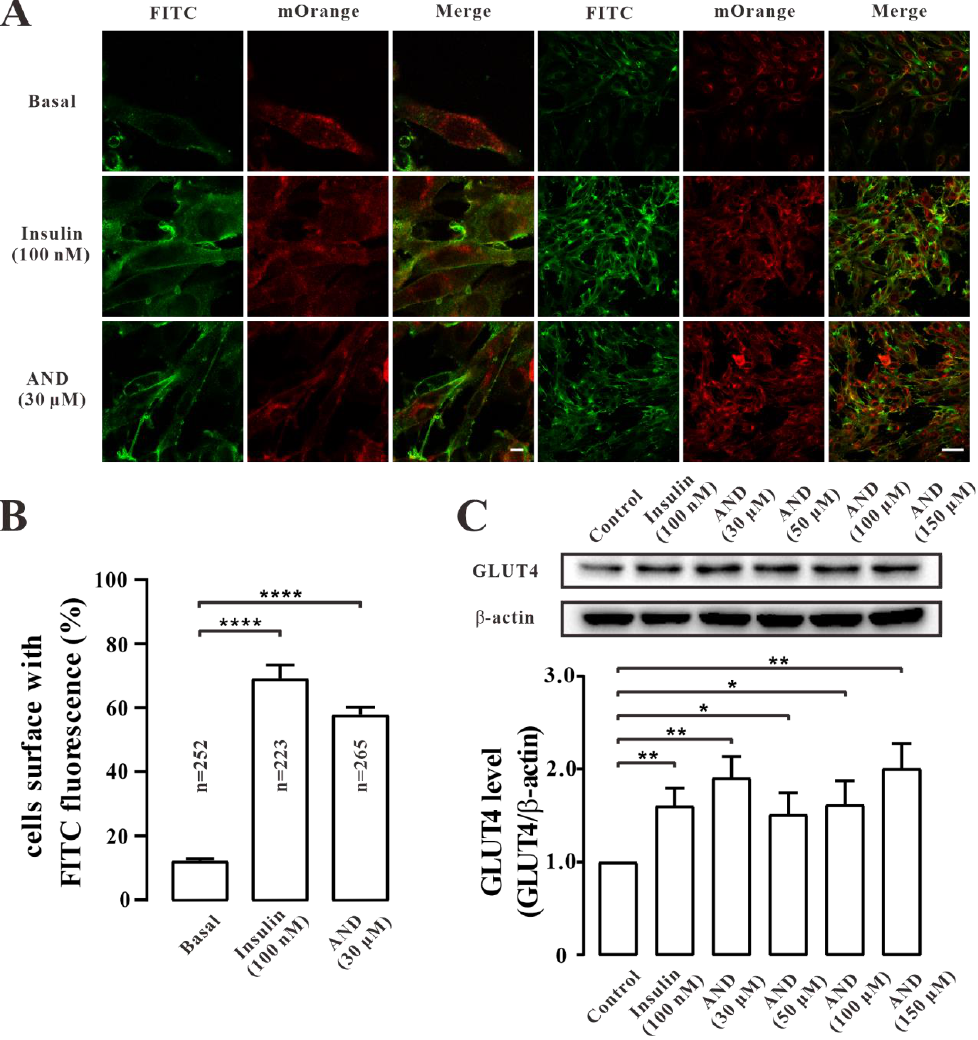
Figure 5. AND promoted GLUT4 expression and fusion into plasma membrane. ( A ) FITC fluores- cence analysis of L6 cells treated with AND or Insulin. Scale bar: 10 μm for single-cell images and 50 μm for multi-cell images. ( B ) The number of GLUT4-mOrange-positive cells, the data represent the mean ± s.e.m. of values from three separate experiments with between 200 and 300 cells examined in each experiment. ( C ) The expression level of GLUT4 after treatment with 100 nM insulin or different concentrations of AND for 30 min in L6 cells. The control group was considered as 1 for data analysis. The data represent the mean ± s.e.m. of values from three separate experiments. *: p < 0.05; **: p < 0.01; ****: p < 0.0001.